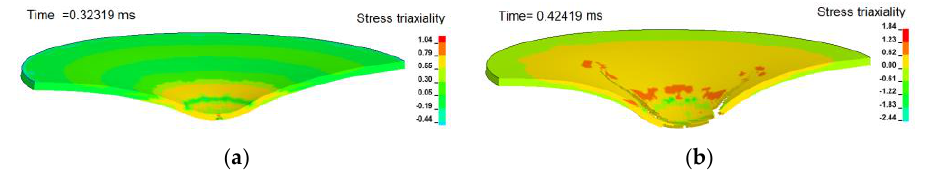
Figure 9. ( a ) Calculated distribution of stress triaxiality parameter in the cross-section of a punched Ti-5Al-2.5Sn plate at the time of 0.32319 ms and ( b ) at the time of 0.42419 ms. The velocity of the punch is 15 m/s.